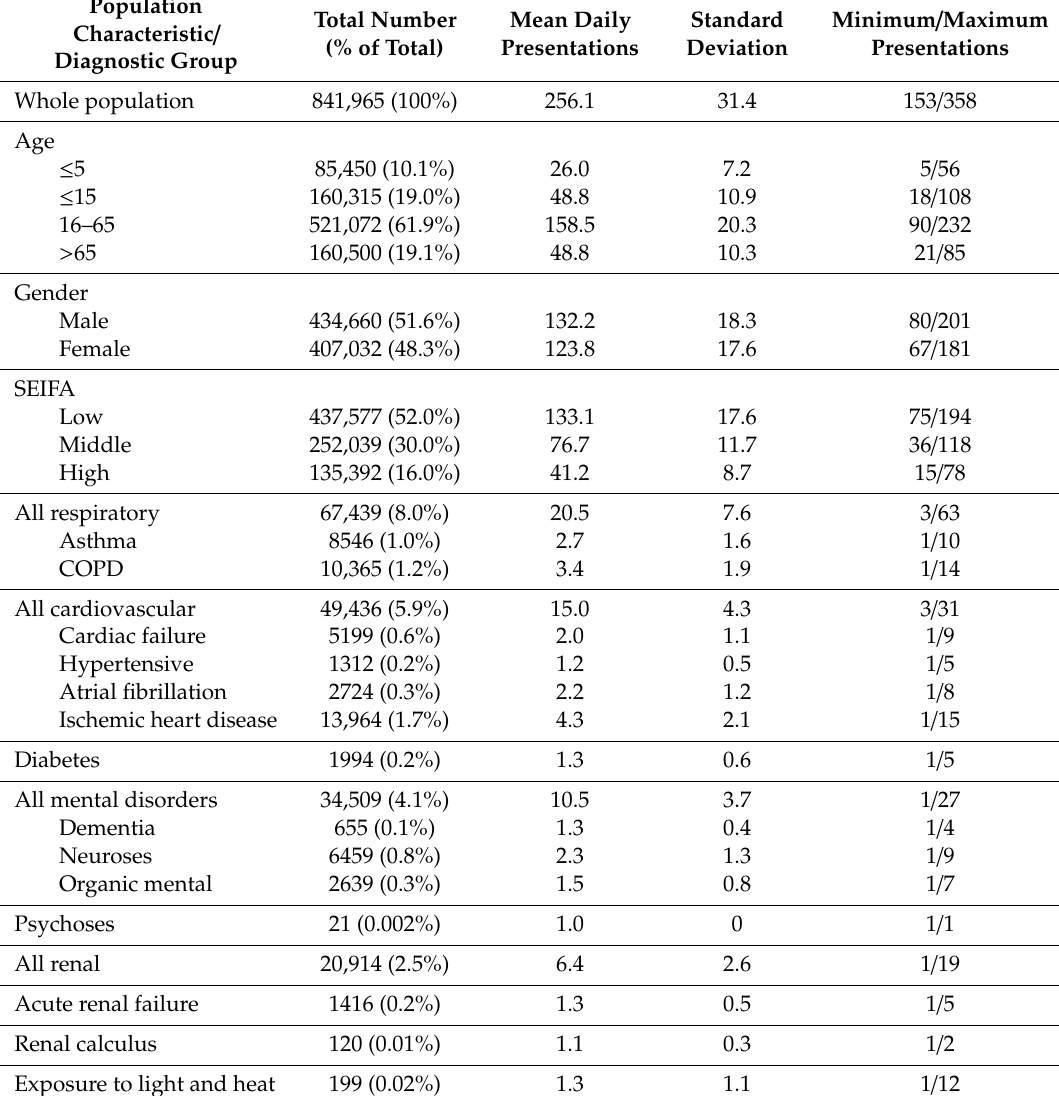
Table 2. Characteristics of emergency department (ED) presentations to the Royal Hobart Hospital and Launceston General Hospital for specific population characteristics and diagnostic groups (2008–2016).